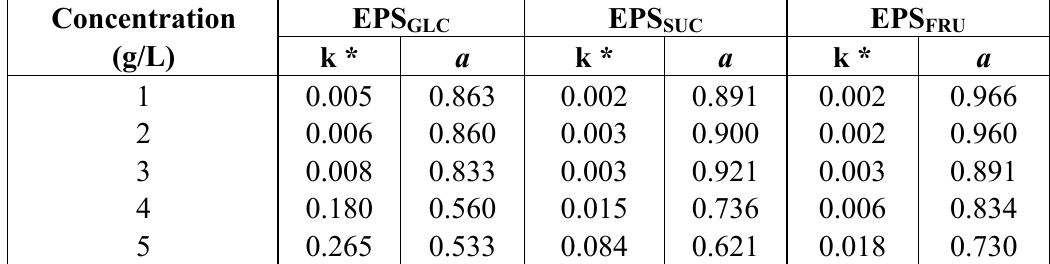
Table 1. Values for consistency index or relaxation time (k) and Power Law index ( a ) for each concentration of the different botryosphaerans. These values confirmed the information presented in Figure